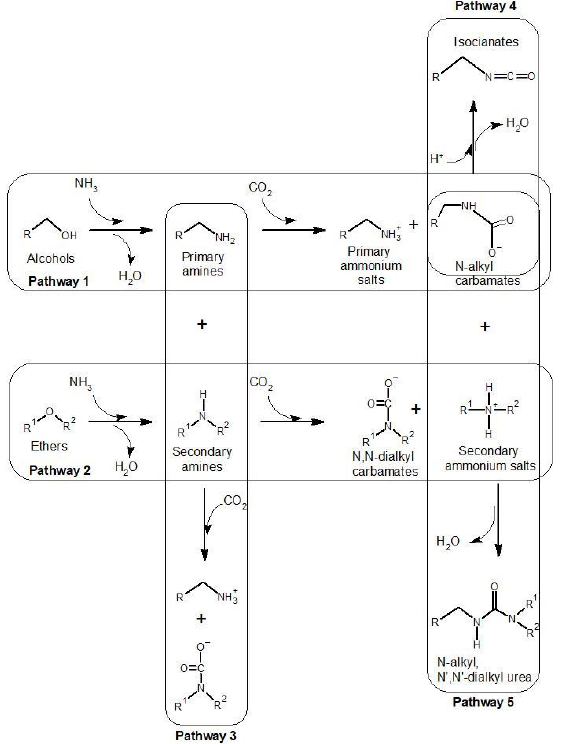
Figure 8. Chemical pathways involved in the changes of biomass surface chemistry during the pyrol- ysis in CO 2 /NH 3 atmosphere. All the reactions described here do not account for the stoichiometry. The scheme has been re-elaborated from references